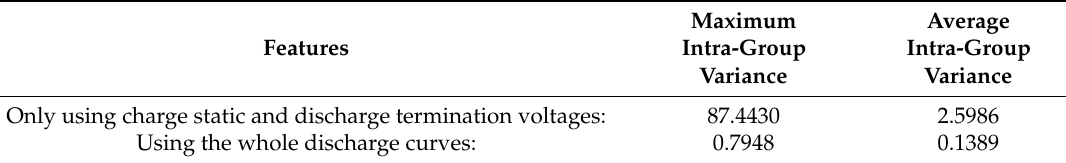
Figure 8. Another successful-grouping battery pack of our method using the complete discharge curves. Note that the discharge curves of this battery pack are very close to each other. Table 1. Comparison of the intra-group variances of the proposed grouping method using different grouping